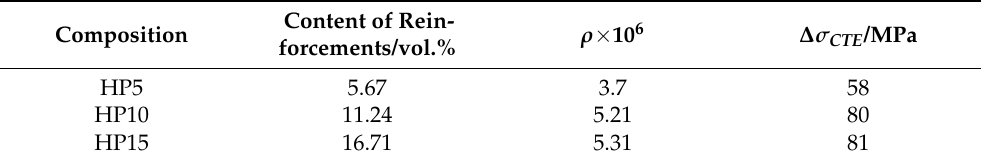
Table 4. Parameters and strengthening contribution from thermal mismatch strengthening mecha- nisms of the Ni-20Cr-Eu 2 O 3 composites with different mass ratios in Eu 2 O 3 (MPa). Content of Rein- Composition